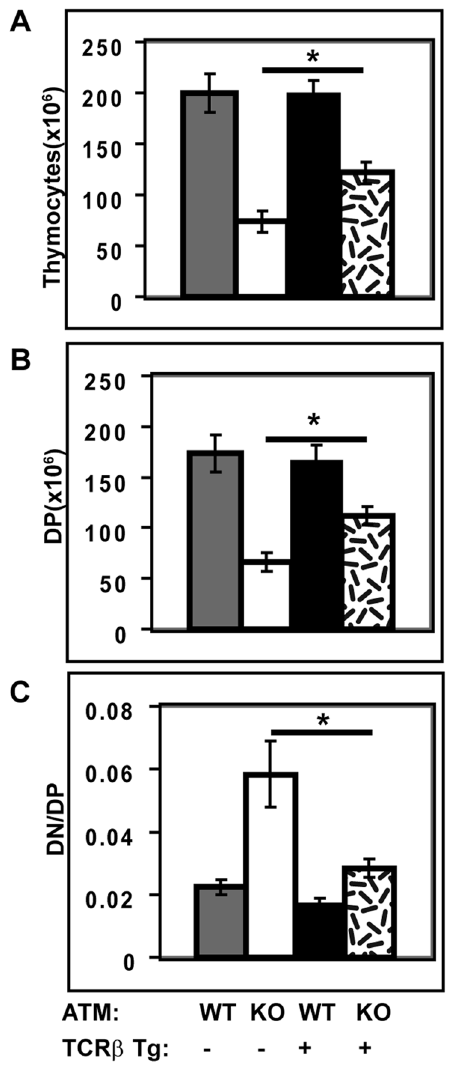
Figure 6. Introduction of a rearranged TCR b TG significantly improves the ATMKO defect in DN to DP development. Effects of TCR b TG expression on ATMWT (WT) and ATMKO (KO) thymic cellularity (A), numbers of DP cells (B), and DN/DP ratios (C). Results in panels A–C are mean ( 6 SEM) for three ATMWT and KO pairs analyzed in three independent experiments. For the parameters that were tested, ATMWT thymi with and without the TCR b TG did not differ significantly. In contrast, ATMKO thymi with and without the TCR b TG did differ significantly (p , 0.05). P values were calculated using Student’s paired 1-tailed t